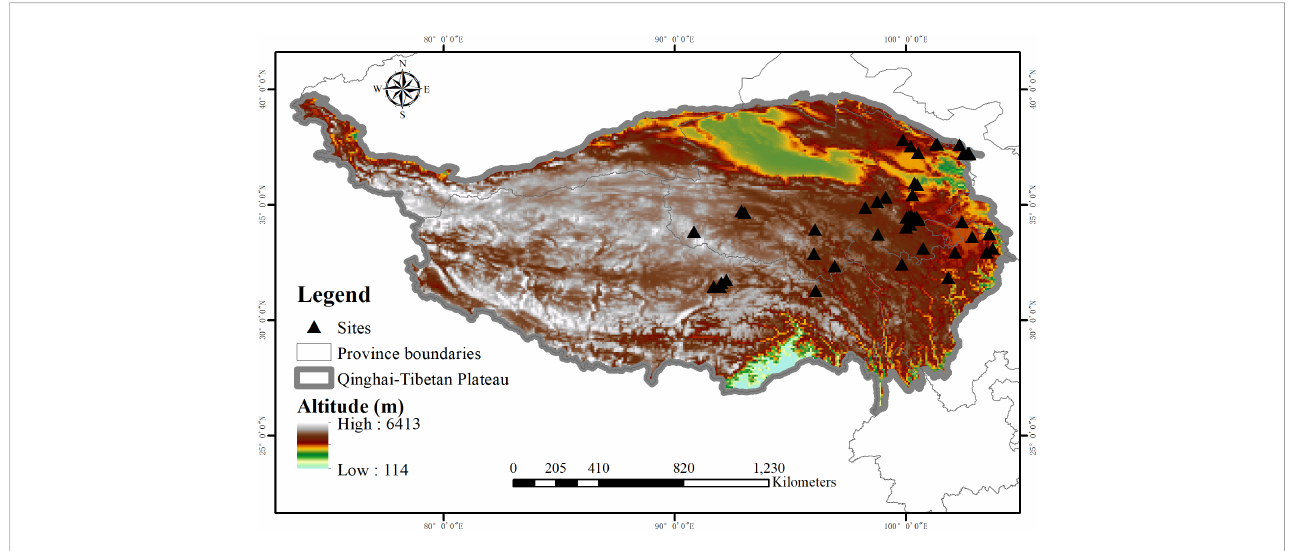
FIGURE 1 Distribution of alpine grassland sites across the Qinghai-Tibetan Plateau of the collected datasets in this